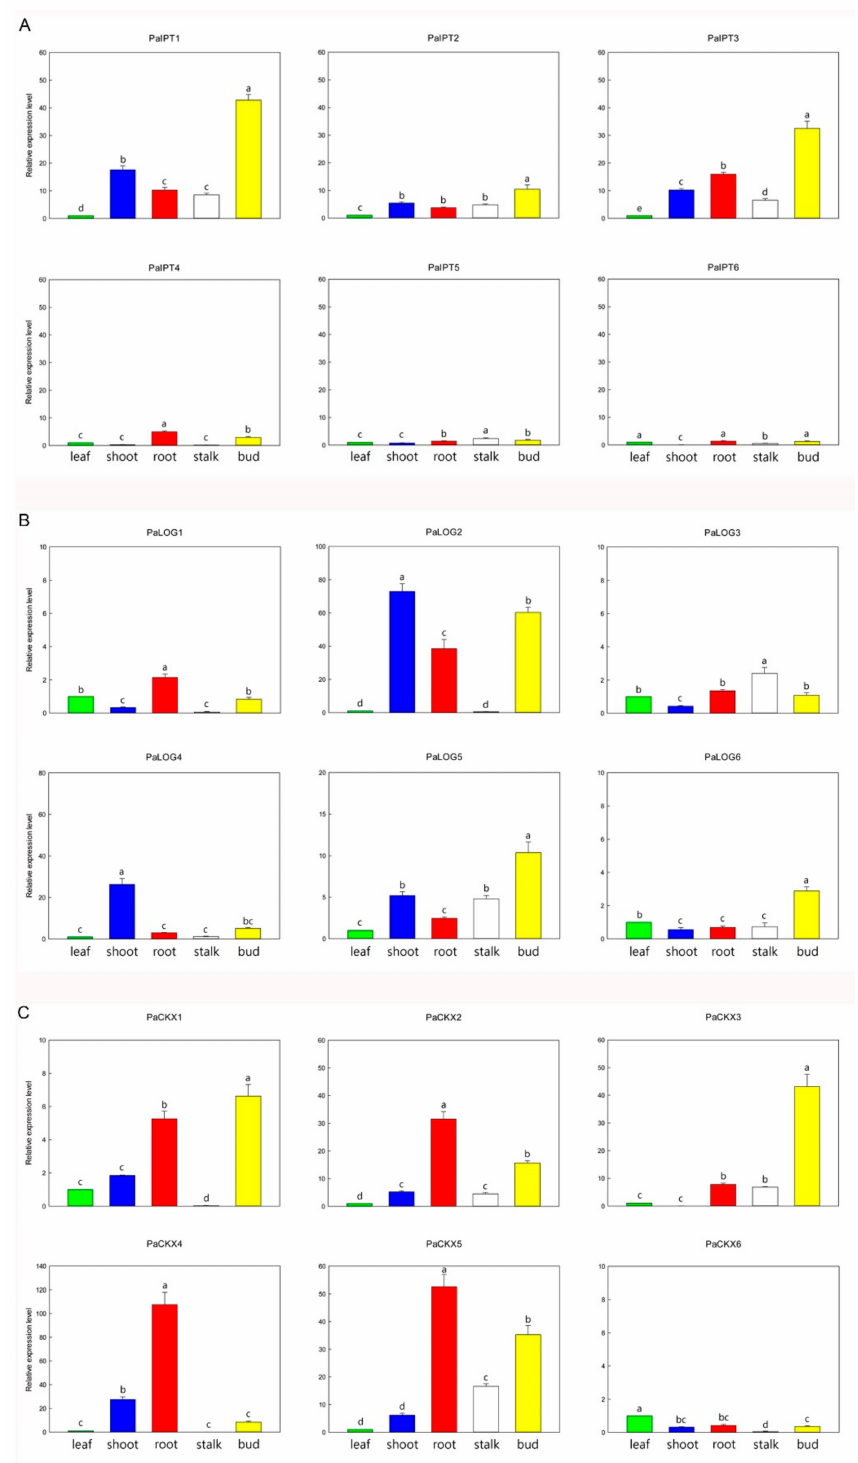
Figure 2. Relative expression levels of PaIPTs ( A ), PaLOGs ( B ), and PaCKXs ( C ) in various organs, including leaf, shoot, root, flower stalk (stalk), and flower bud (bud). Data are the mean of three biological replicates and error bars represent ± standard deviations. Data were analyzed using one-way ANOVA with Tukey’s honest significant difference (HSD) test, and significant differences are indicated by different letters at p < 0.05